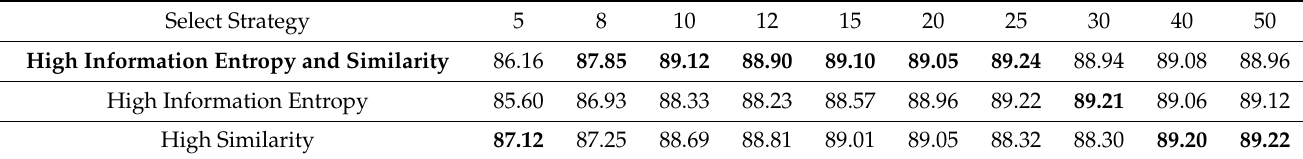
Table 2. OA of KNN classifier on Salinas dataset (%). Our method is highlighted in bold.